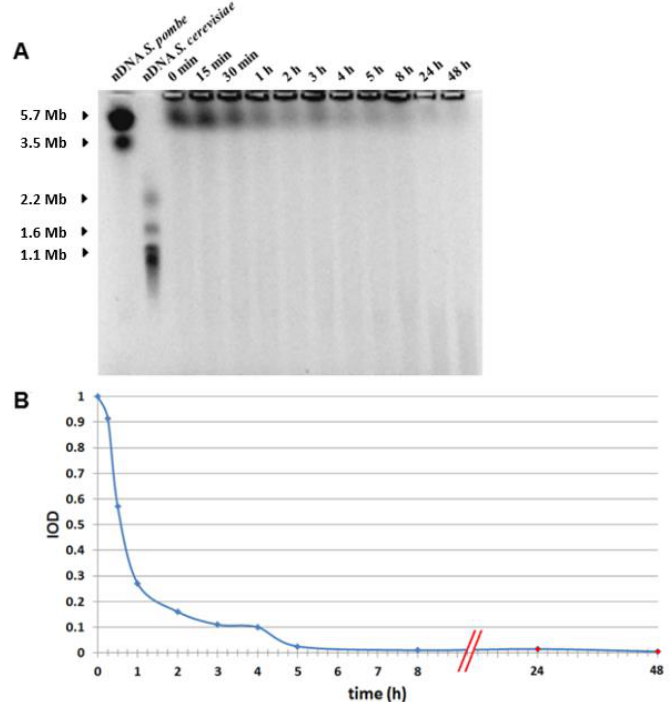
Figure 6. Representative PFGE (A) and qantification of DSB by IOD (B) showing DSB repair. Nuclear DNA was isolated from human lymphocytes at different time points after γ-irradiation with 3 Gy. ( A ) Markers: unirradiated nDNA of S. pombe (line 1) and S. cerevisiae (line 2). Lines 3-13 show the Mb-sized compression zone of fragmented DNA, which decreases with time after irradiation. ( B ) IOD manifests fragmented nuclear DNA due to DSB. Maximum IOD indicating the immediate formation of DSB is observed immediately after irradiation followed by decrease with post-irradiation time due to DSB repair. Almost all DSB are repaired by 5 h post-irradiation.